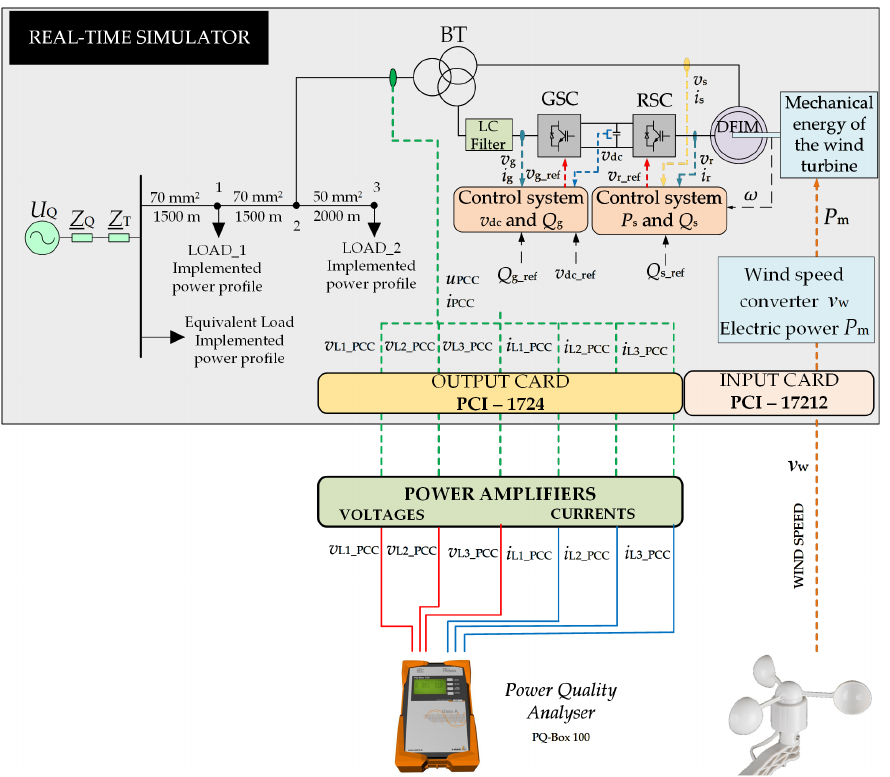
Figure 17. Diagram of the experimental system.